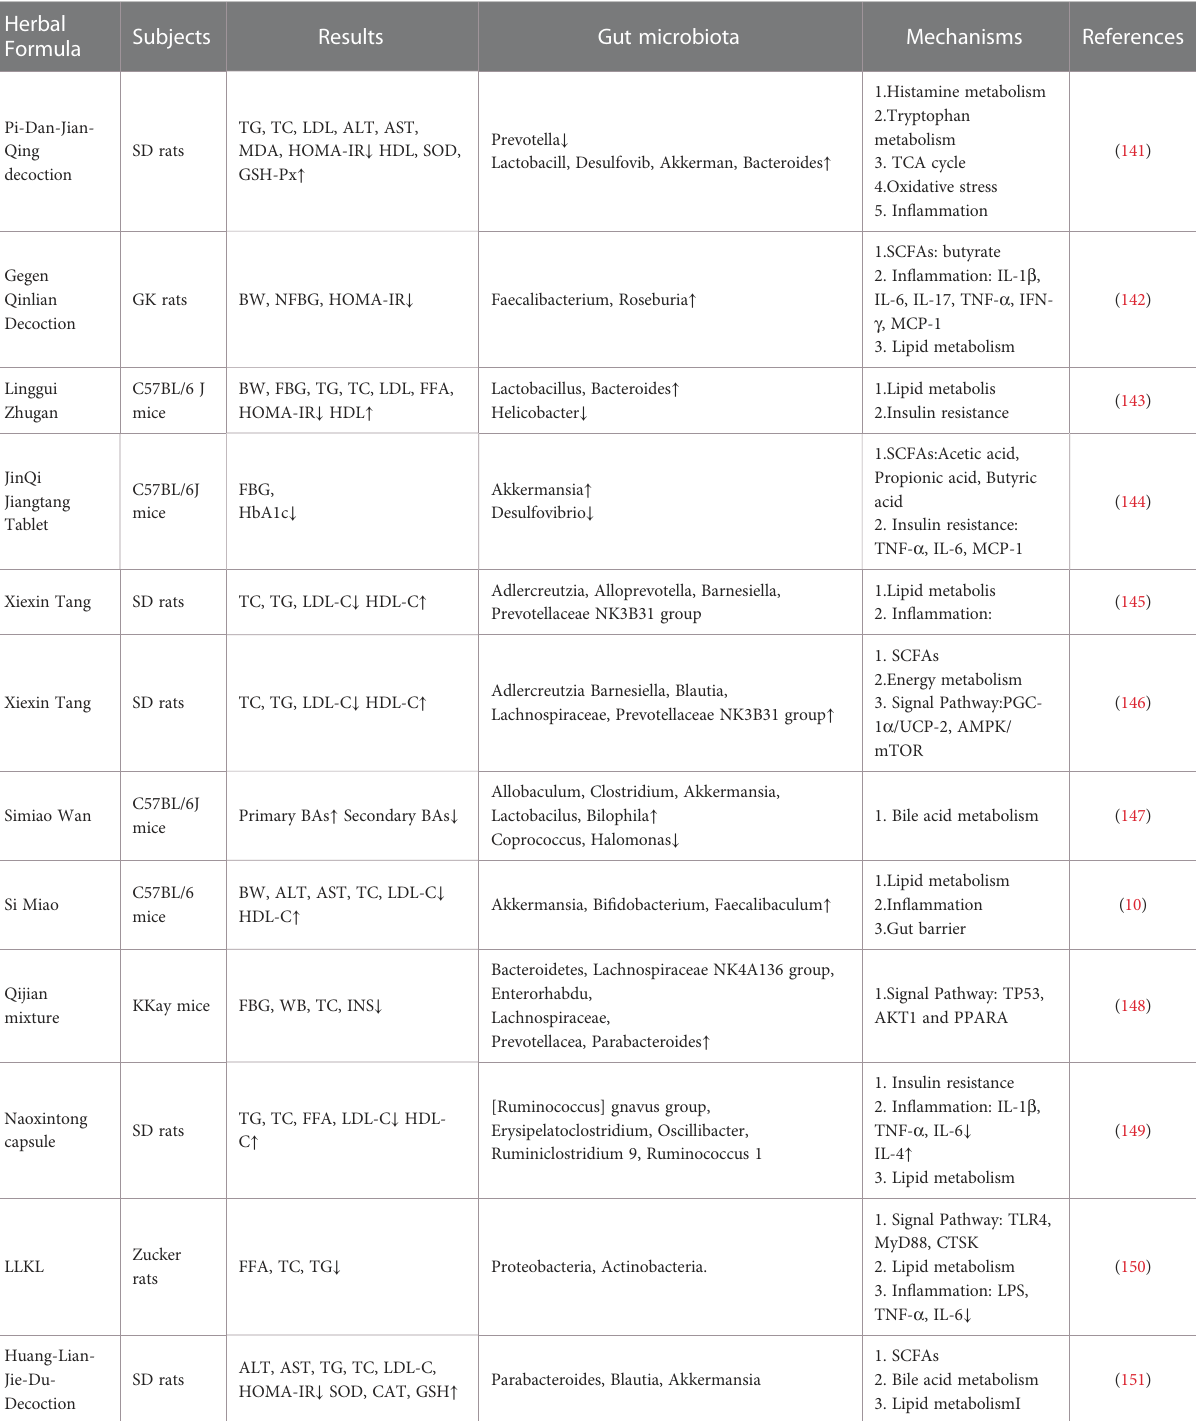
TABLE 2 The mechanism of action of Chinese Herbal